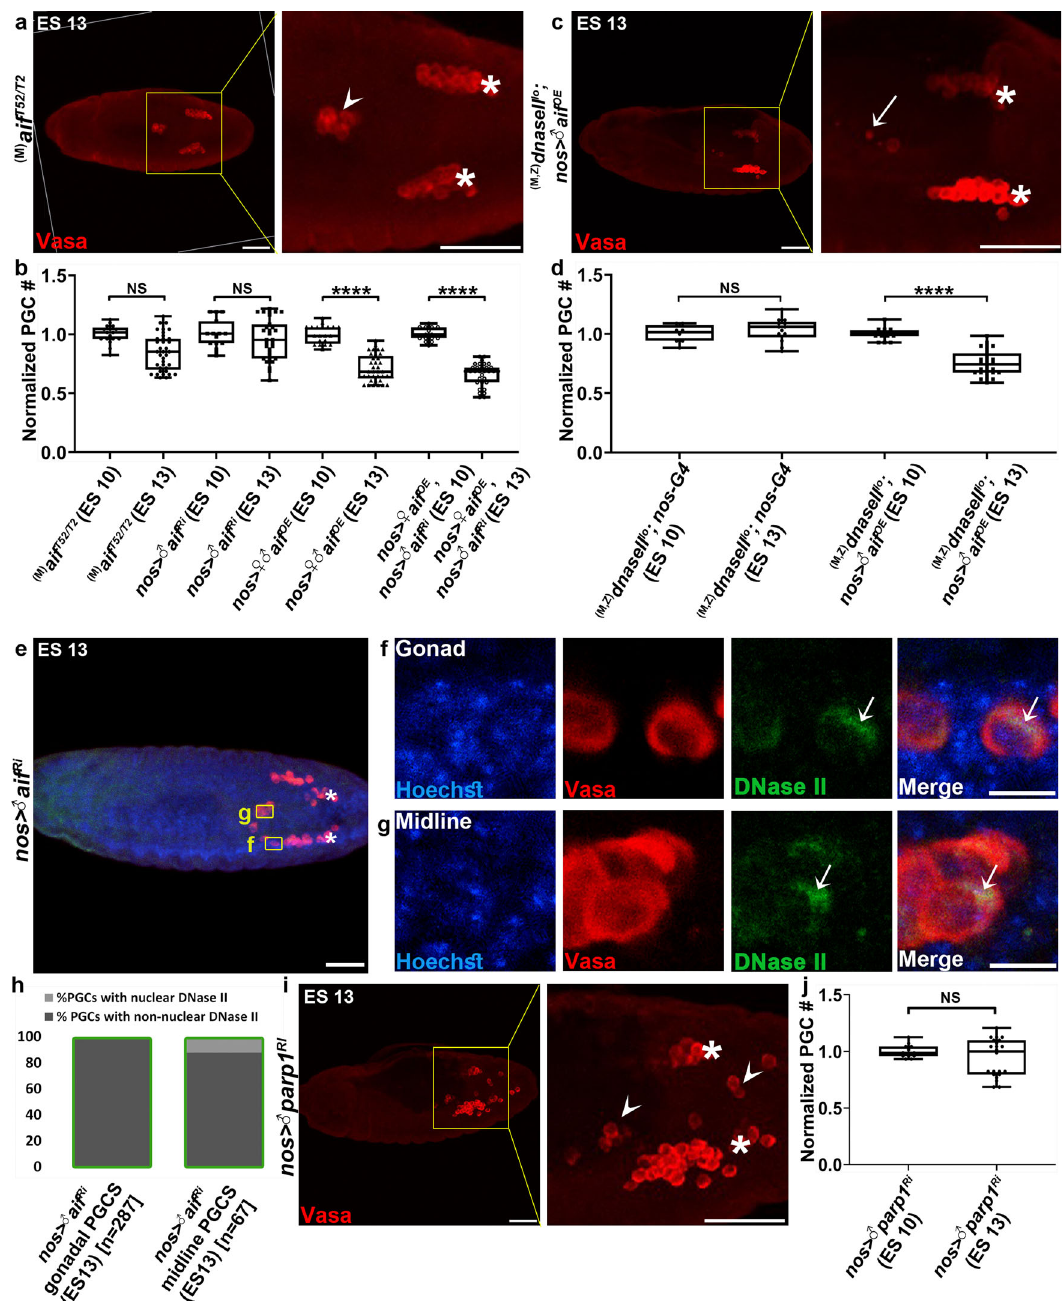
UniProt for CypA-like protein sequences, revealed 4 different gene products with a cyclophilin-like domain, Cyp1, CG2852, CG17266, and Moca-cyp, sharing 77%, 59%, 57%, and 55% sequence identity with human CypA, respectively. PGC-speci fi c knockdown of cyp1 , CG2852, and CG17266 , each attenuated PGC death in 60% of the embryos, suggesting an involvement and redundancy among at least three of the CypA-like proteins in PGC death (Fig. 8b, c). To investigate whether the cyclophilins might affect DNase II nuclear translocation, we stained cyp1 (the most similar cypA ortholog) knockdown embryos with anti- DNase II antibodies. Whereas in WT embryos 70% of the dying midline PGCs displayed nuclear DNase II localization, 100% of the ectopically surviving midline PGCs in the cyp1 knockdown embryos had no nuclear DNase II, suggesting that the cyclophi- lins affect PGC death by modulating (AIF-mediated) DNase